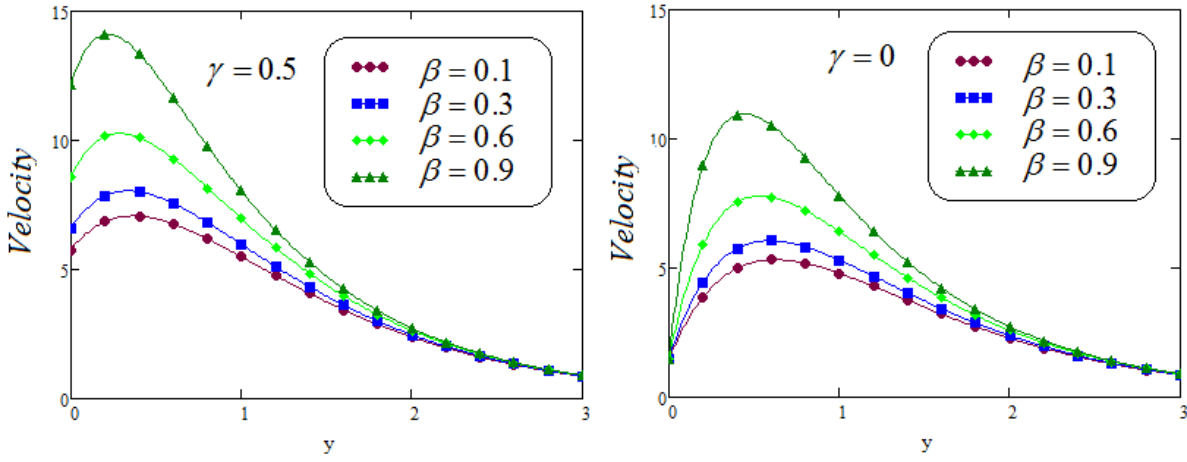
Figure 9. Velocity for varied values of β with and without slip effect γ when f ( t ) = e at , t = 1.5, Gr = 3.5, α = 0.5, λ 1 = 0.6, P r = 0.71, λ 2 = 0.2, M =